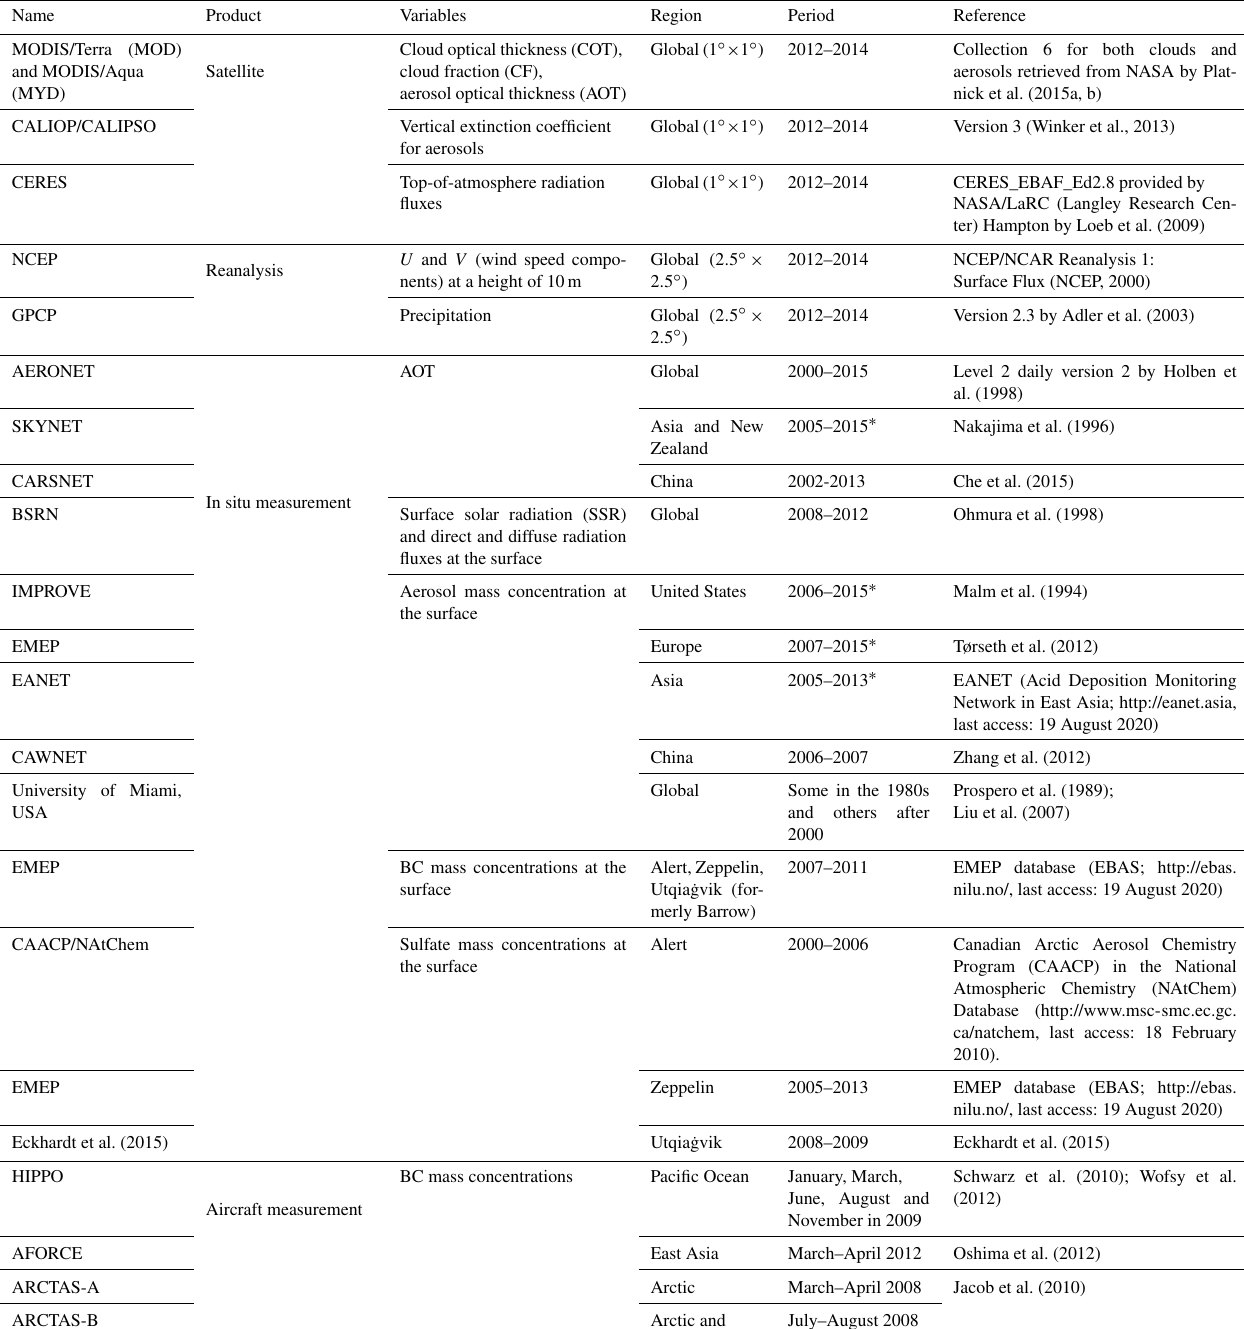
Table 1. Details of the observation